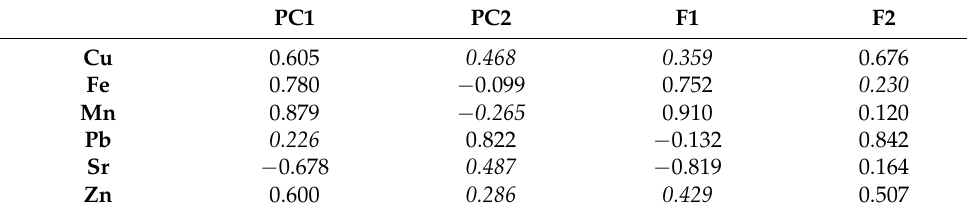
Table 9. PCA initial factor loadings matrix and rotated factor loadings